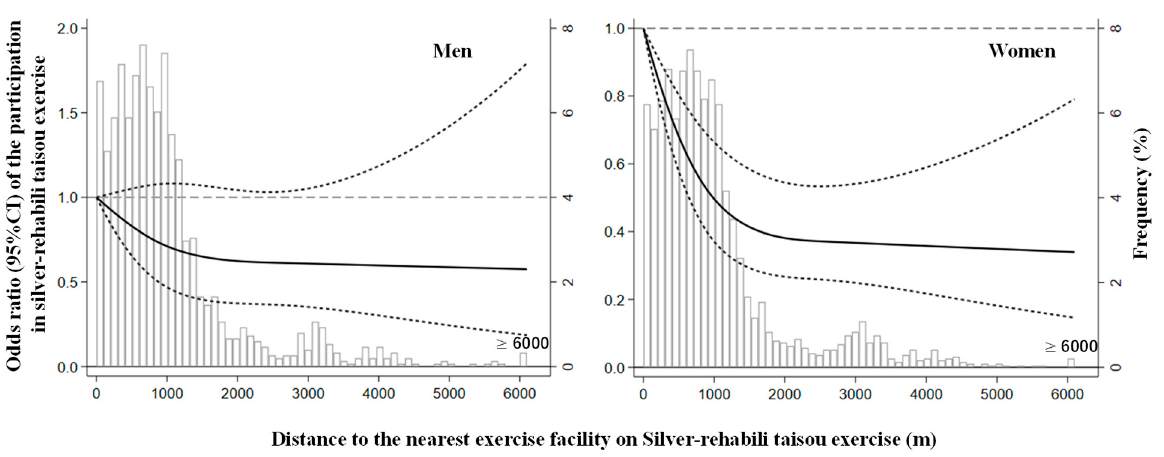
Figure 1. Odds ratio of participation in the silver-rehabili taisou exercise and the distance to a facility in men and women. The solid line represents the odds ratio, and the dashed line represents the 95% confidence intervals. Distance to the nearest exercise facility on silver-rehabili taisou exercise distribution is represented by histograms in the background. Knots were placed at the 10th, 50th, and 90th percentiles of the distance to the exercise facility using < 100 m as the reference point. CI = confidence interval.